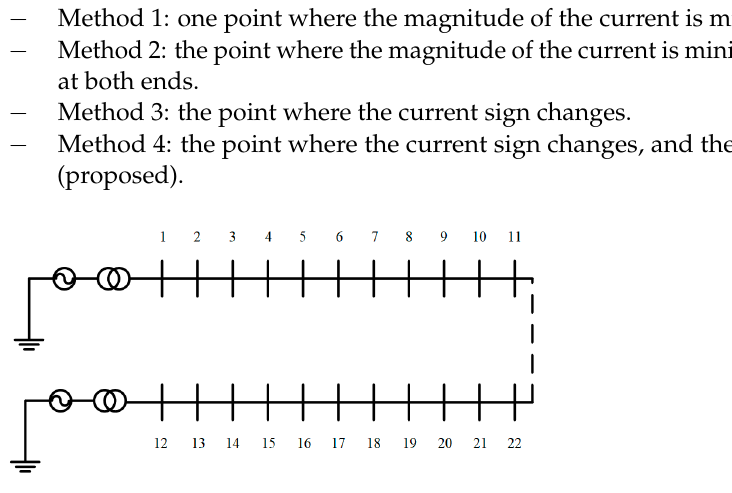
Table 1. Probabilities of finding optimal and suboptimal solutions using each compared method.